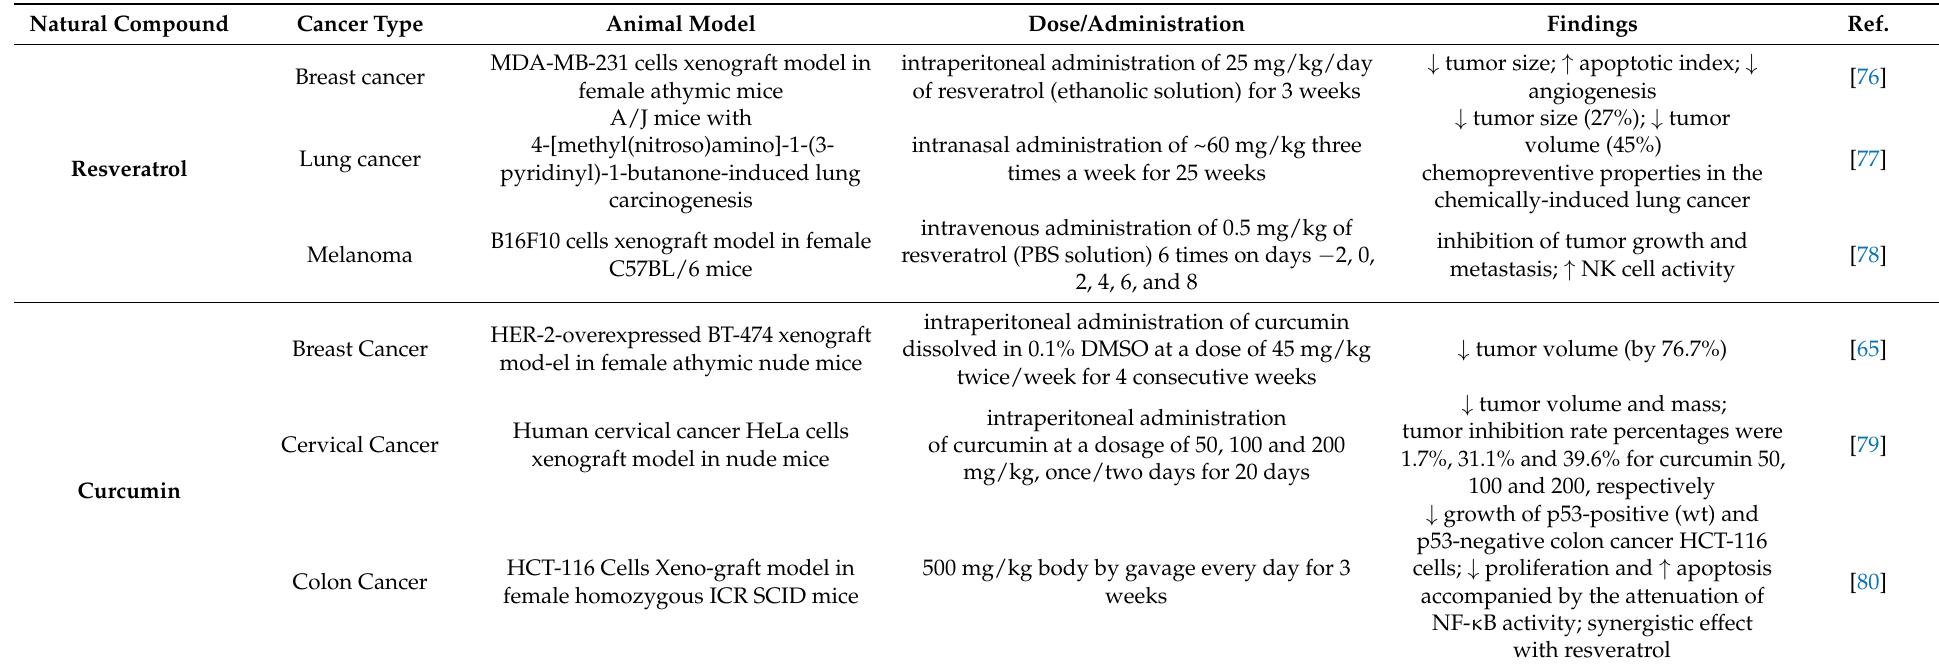
Table 2. In vivo studies achieved after the successes recorded in vitro and promulgated in clinical